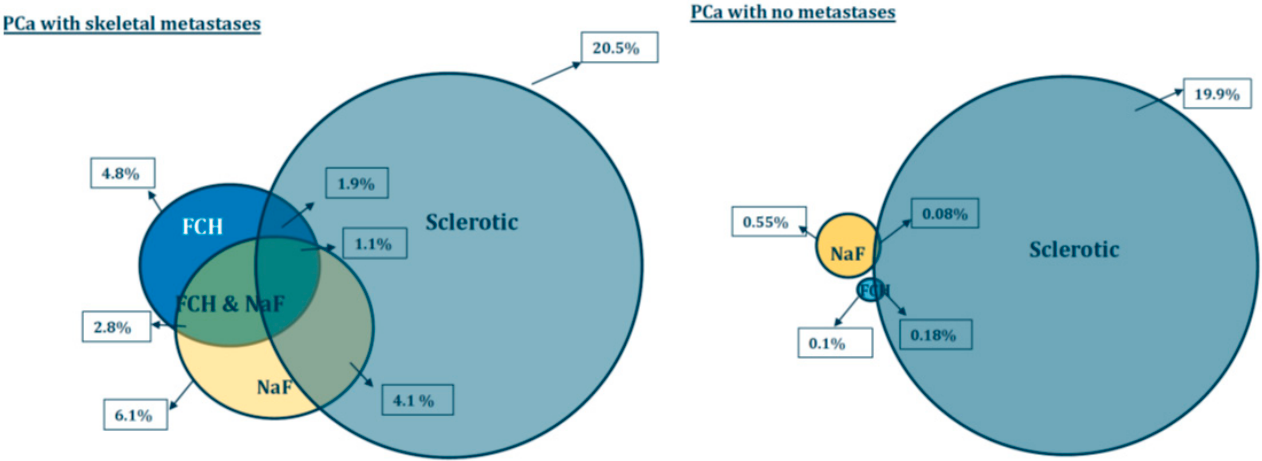
Figure 4. Pathologic PET/CT volumes as percentages of the skeletal volumes (when HU > 150 on CT) are presented as spheres. Pathologic volumes for FCH (SUV > 3.5) are in blue and NaF (SUV > 10) in yellow. Sclerosis is measured from CT (HU > 600) volume (grey). The volumes are shown for patients with bone metastases (M) and for control prostate cancer patients with no skeletal metastases (N). The amount of sclerosis (grey spheres) does not statistically differ in these patient groups. All pathological volumes, including overlapping regions, differ statistically significantly from each other between M and N group.